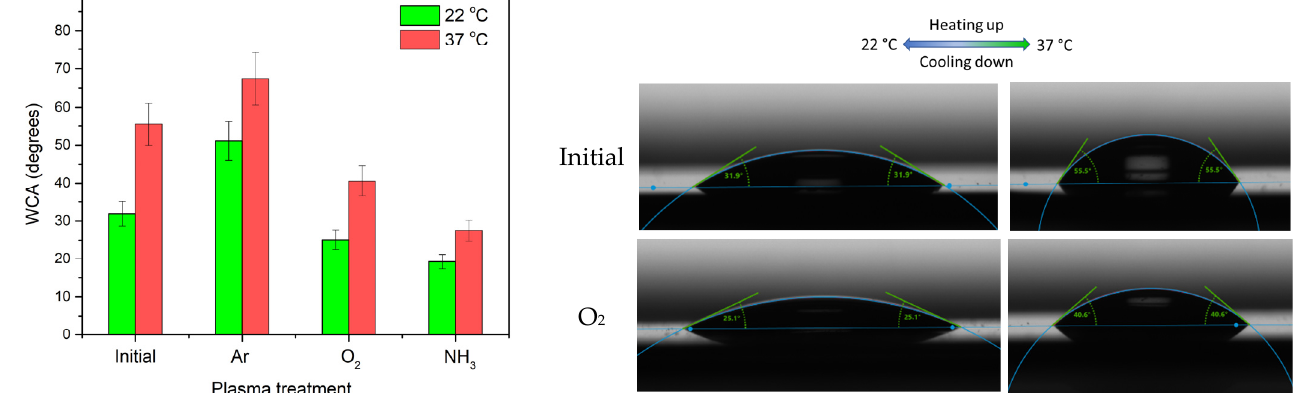
Figure 8. Left —WCA at 22 °C (below LCST) and 37 °C (above LCST) for the spin-coated pNIPAAM and plasma-treated surfaces in argon, oxygen and ammonia plasmas; Right —images of the droplets on the surface of initial and oxygen plasma-treated pNIPAAM, below and above LCST.